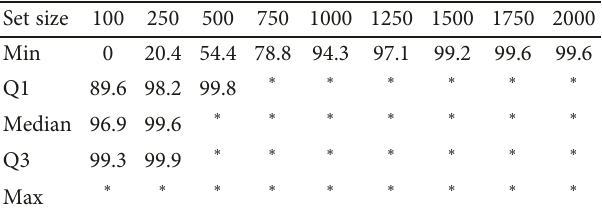
Table 1 Shawn Bradley ’ s height score quickly stabilizes at the highest rank as SNP-set size increases. Data are represented in percentiles. The “ ∗ ” indicates that his score was the highest.